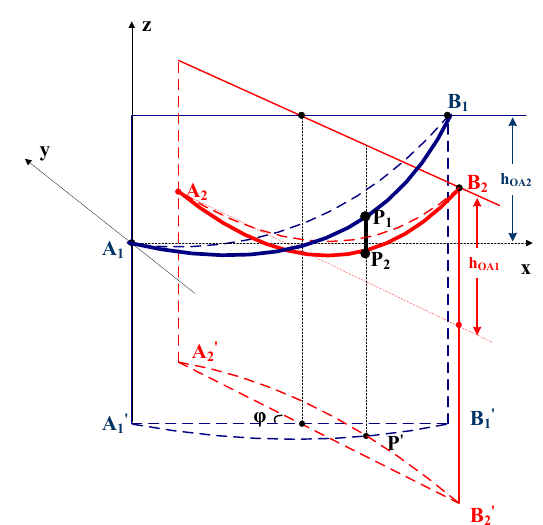
Figure 4. The diagrammatic sketch of crossed span under wind condition According to the Newton iteration method, from the second equation in equations (12) and (13), the coordinates (x', y') of P' can be obtained and taken into the first equation, then the z value can be obtained. At last, the crossed span distance of two power transmission lines under the wind deflection is calculated: | | | | , where z 1 and z 2 are the z-axis coordinates of the points P 1 and P 2 , respectively.